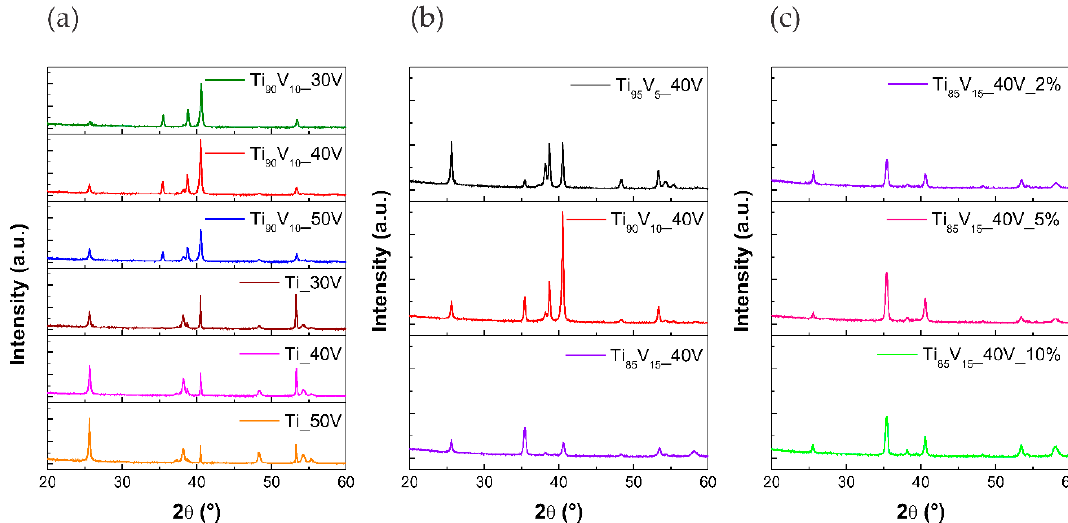
Figure 6. X-ray diffraction (XRD) spectra of pristine TiO 2 NTs and V 2 O 5 -TiO 2 NS. Effect of ( a ) anodization potential; ( b ) vanadium content in the alloy; and ( c ) water content in the electrolyte.